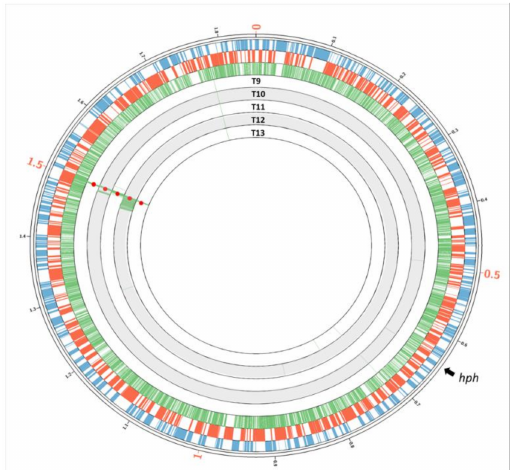
Figure 3. Chimeric nature of the chromosome of transjugants derived from HB8. External blue and red circles indicate the forward and reverse annotated ORFs in the chromosome of the HB8 strain, respectively. Green bars in the first internal circle indicate the positions of the SNPs present in the chromosome of the HB27 strain. Underlying concentric circles correspond to the genome of transjugants T9 to T13. The presence of green lines denotes SNPs acquired from the HB27 strain. Positions of the kat and hph genes are labeled in red dots and black arrow,